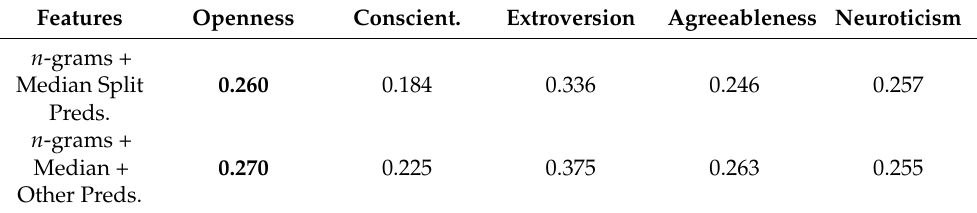
Table 6. Pearson correlation coefficient between the actual Big Five traits and the predictions achieved through usage of n -grams, MBTI/Enneagram predictions and median-split Big Five predictions as features. Features Openness Conscient.